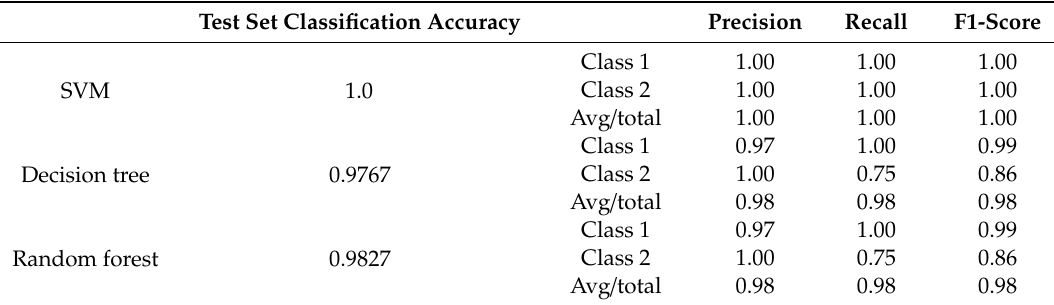
Table 6. Three classifier experimental results of two categories.